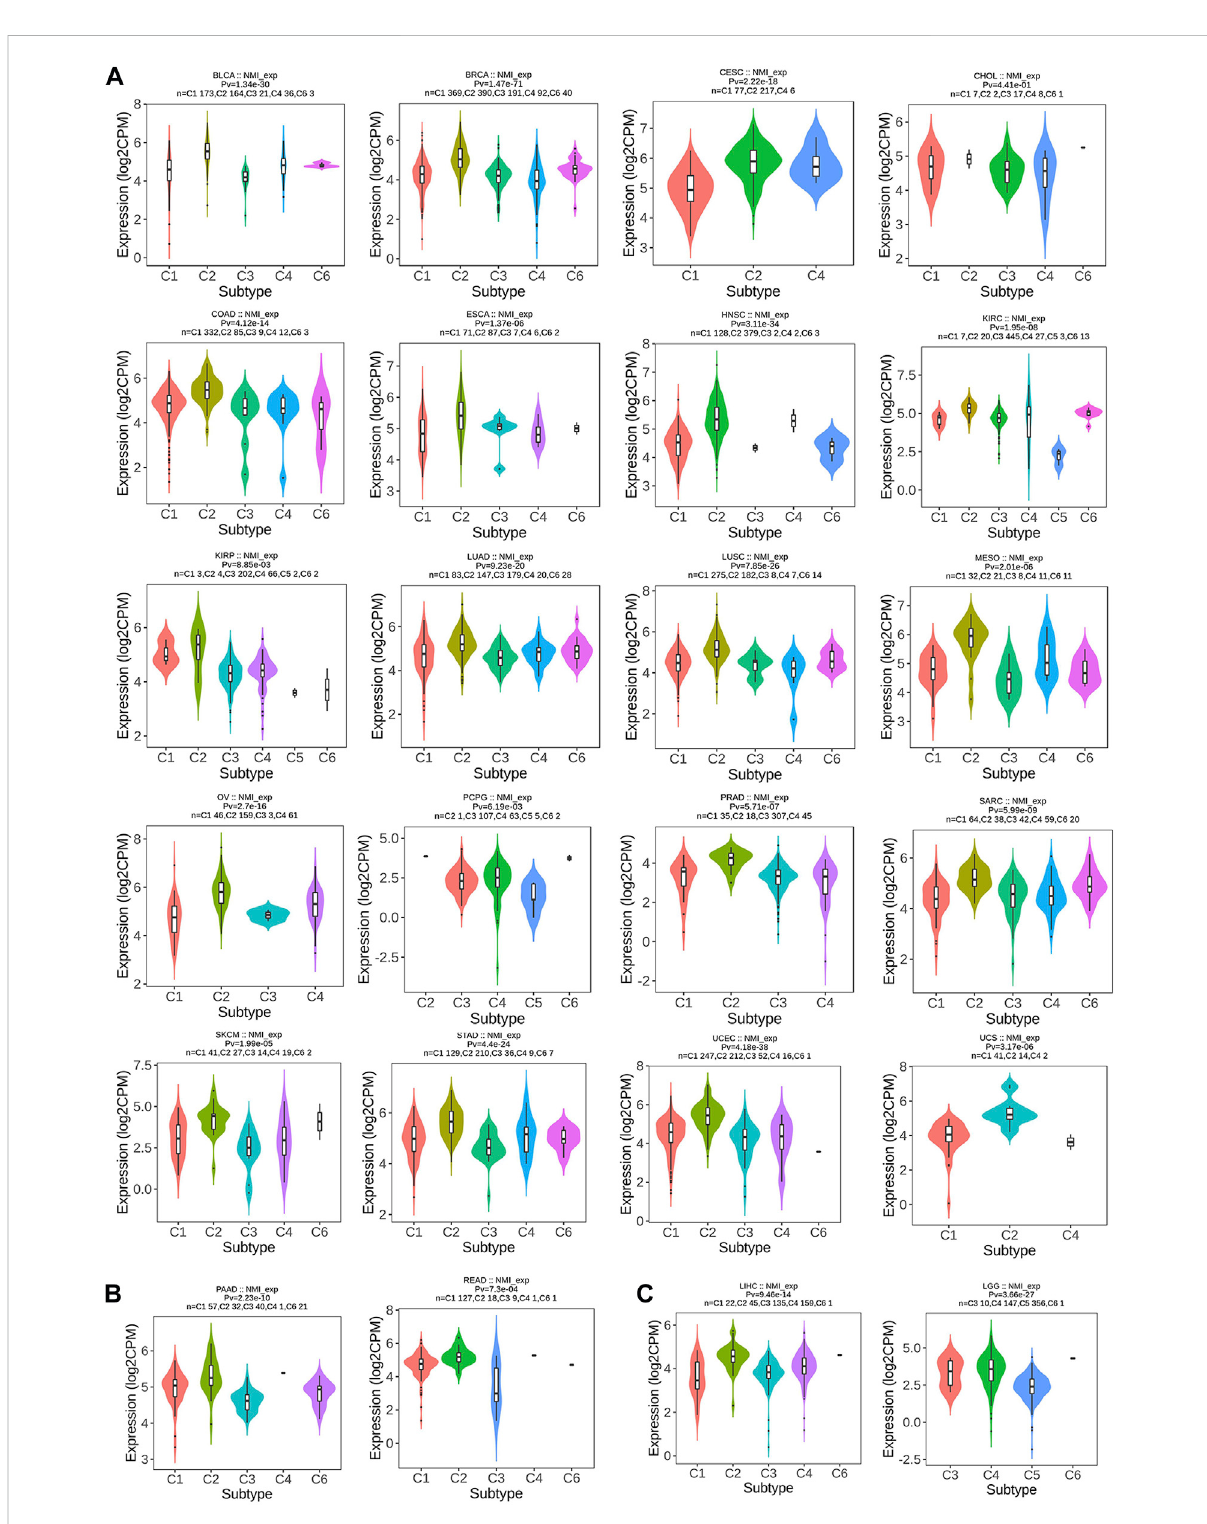
FIGURE 3 Correlation analysis between NMI expression and tumor immune subtypes. (A) BLCA, BRCA, CESC, CHOL, COAD, ESCA, HNSC, KIRC, KIRP, LUAD, LUSC, MESO, OV, PCPG, PRAD, SARC, SKCM, STAD, UCEC, and UCS. (B) PAAD and READ. (C) LIHC and